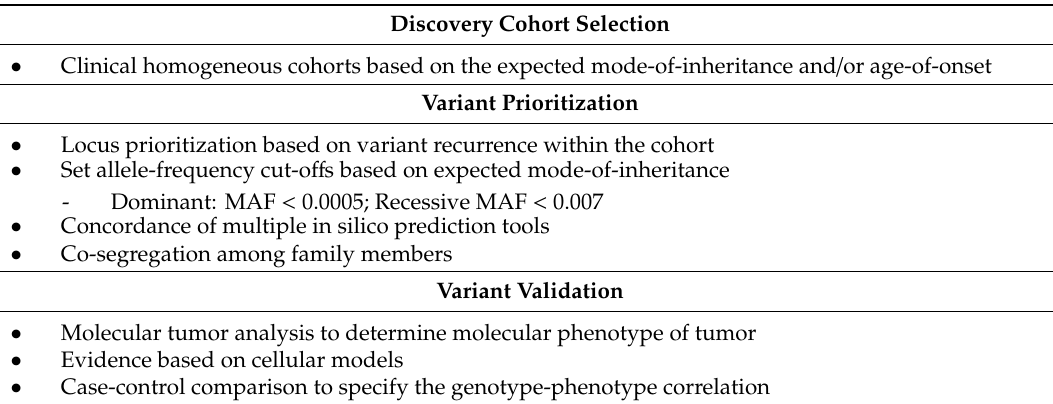
Table 2. Summary of considerations for future candidate gene discovery